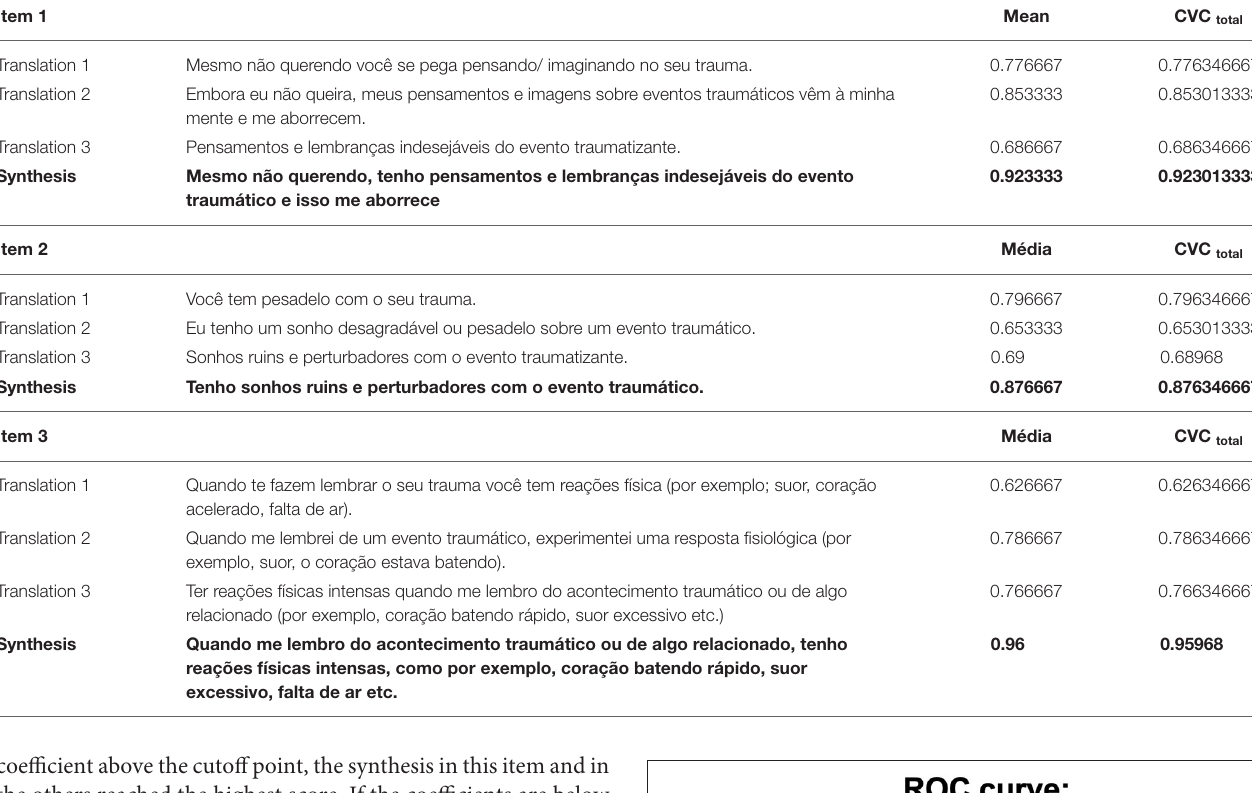
TABLE 1 | Brazilian translation and synthesis of the three Short-Version-PDS items.